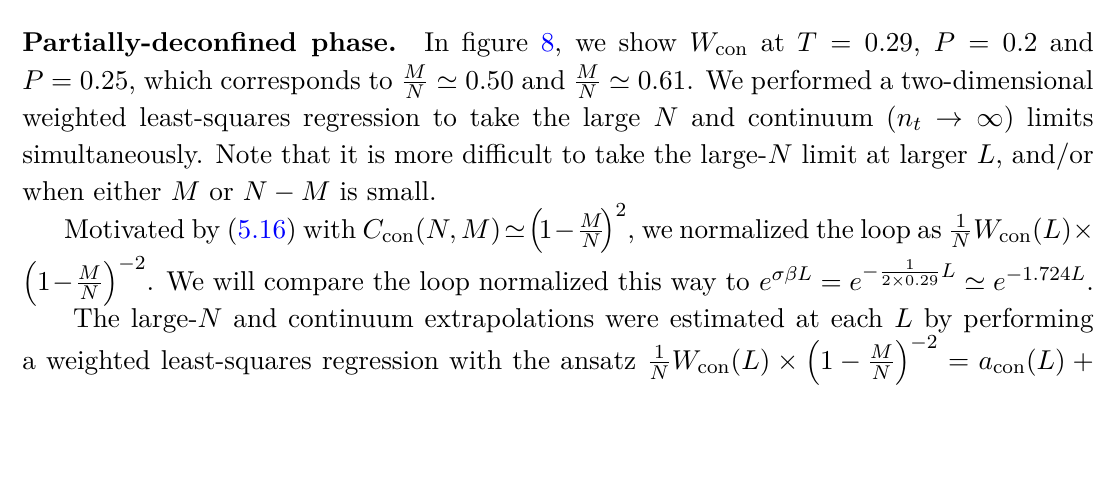
Figure 8. Confined subsector Wilson loop, W con , at T = 0 . 29 , for P = 0 . 2 and P = 0 . 25 , respectively. We have extrapolated to the large N limit using N = 24 , 32 , 64 , and to the continuum limit using n t = 16 , 24 , 32 for each N , using the 2D interpolation 1 β 1 + β 2 + β 2 . We fitted these interpolated values γ con ( L ) for 1 ≤ L ≤ 4 to the ansatz γ con ( L ) = N 2 n t n t N 2 exp( − c con L + d con ) and obtained c con = 1 . 729(17) and c con = 1 . 724(23) for P = 0 . 2 and P = 0 . 25 , respectively. The fit is shown along with error bounds by the blue